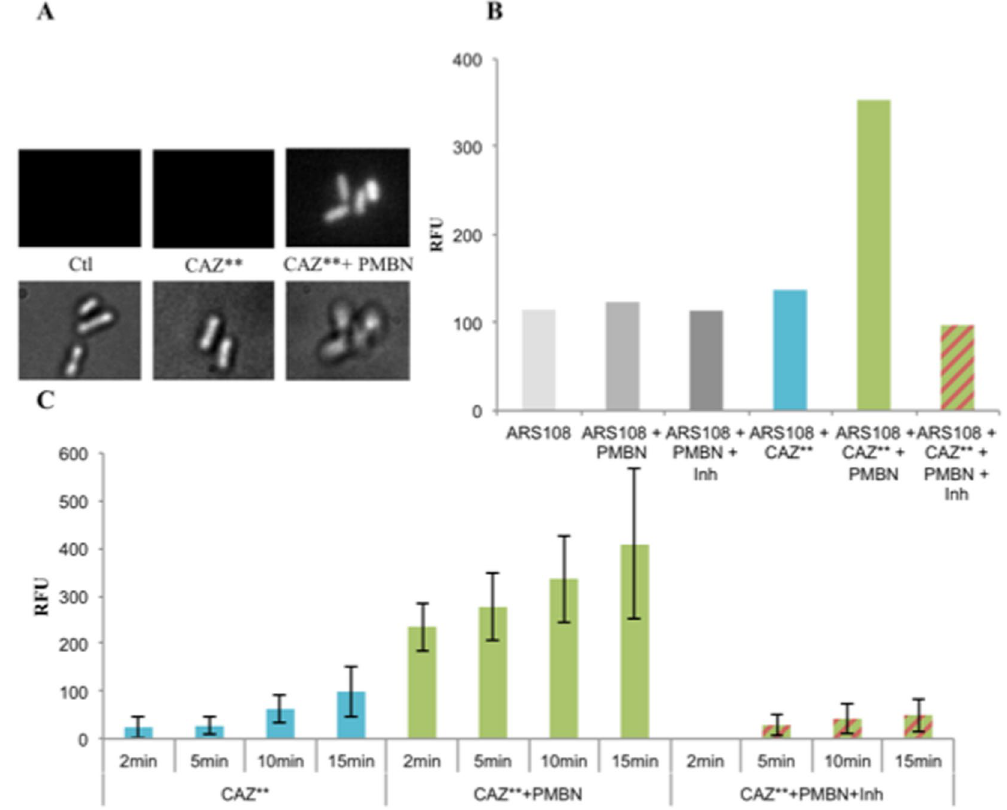
Figure 4. CAZ ** accumulation associated with β -lactamase activity in individual bacterial cell devoid of porin. ( A ) Images acquired on DUV microscope. At the bottom, bacteria under visible transmitted light and at the top, the same bacteria excited at 320 nm and emission between 370 and 410 nm. The images showed ARS108 alone (Ctrl), CAZ ** with ARS108 and with ARS108 + PMBN at 2 min incubation. ( B ) Fluorescence of CAZ ** after 2 min of monitoring corrected by the tryptophan signal. ( C ) Time-courses of CAZ ** accumulation: the fluorescence of 6-MeOQ were indicated for the various incubation times and corrected by the tryptophan signal. PMBN: final concentration 102.4 mg/L. Inh: tazobactam + clavulanic acid at 4 mg/L each. The columns with bars (standard deviations) corresponded to measurements carried out with about 40 cells. In all experiments, we measure CAZ ** accumulation via the β -lactamase activity that unmasks the fluorescent 6-MeOQ. In the presence of inhibitors (tazobactam + clavulanic acid), the 6-MeOQ release is inhibited. It is important to mention that we cannot detect the β -lactam ring cleavage by PBPs because the turnover of this enzyme is too slow to observe the cleavage product 45